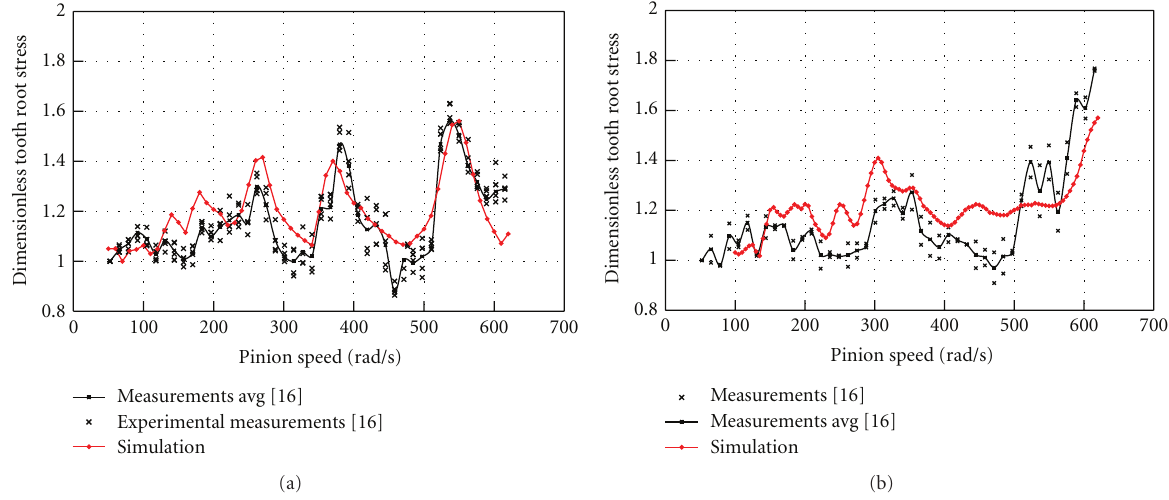
Figure 4: Comparisons between the simulated and measured local dynamic coe ffi cient with C r = 1540 N · m (a) maximum bearing spacing; and (b) minimum bearing